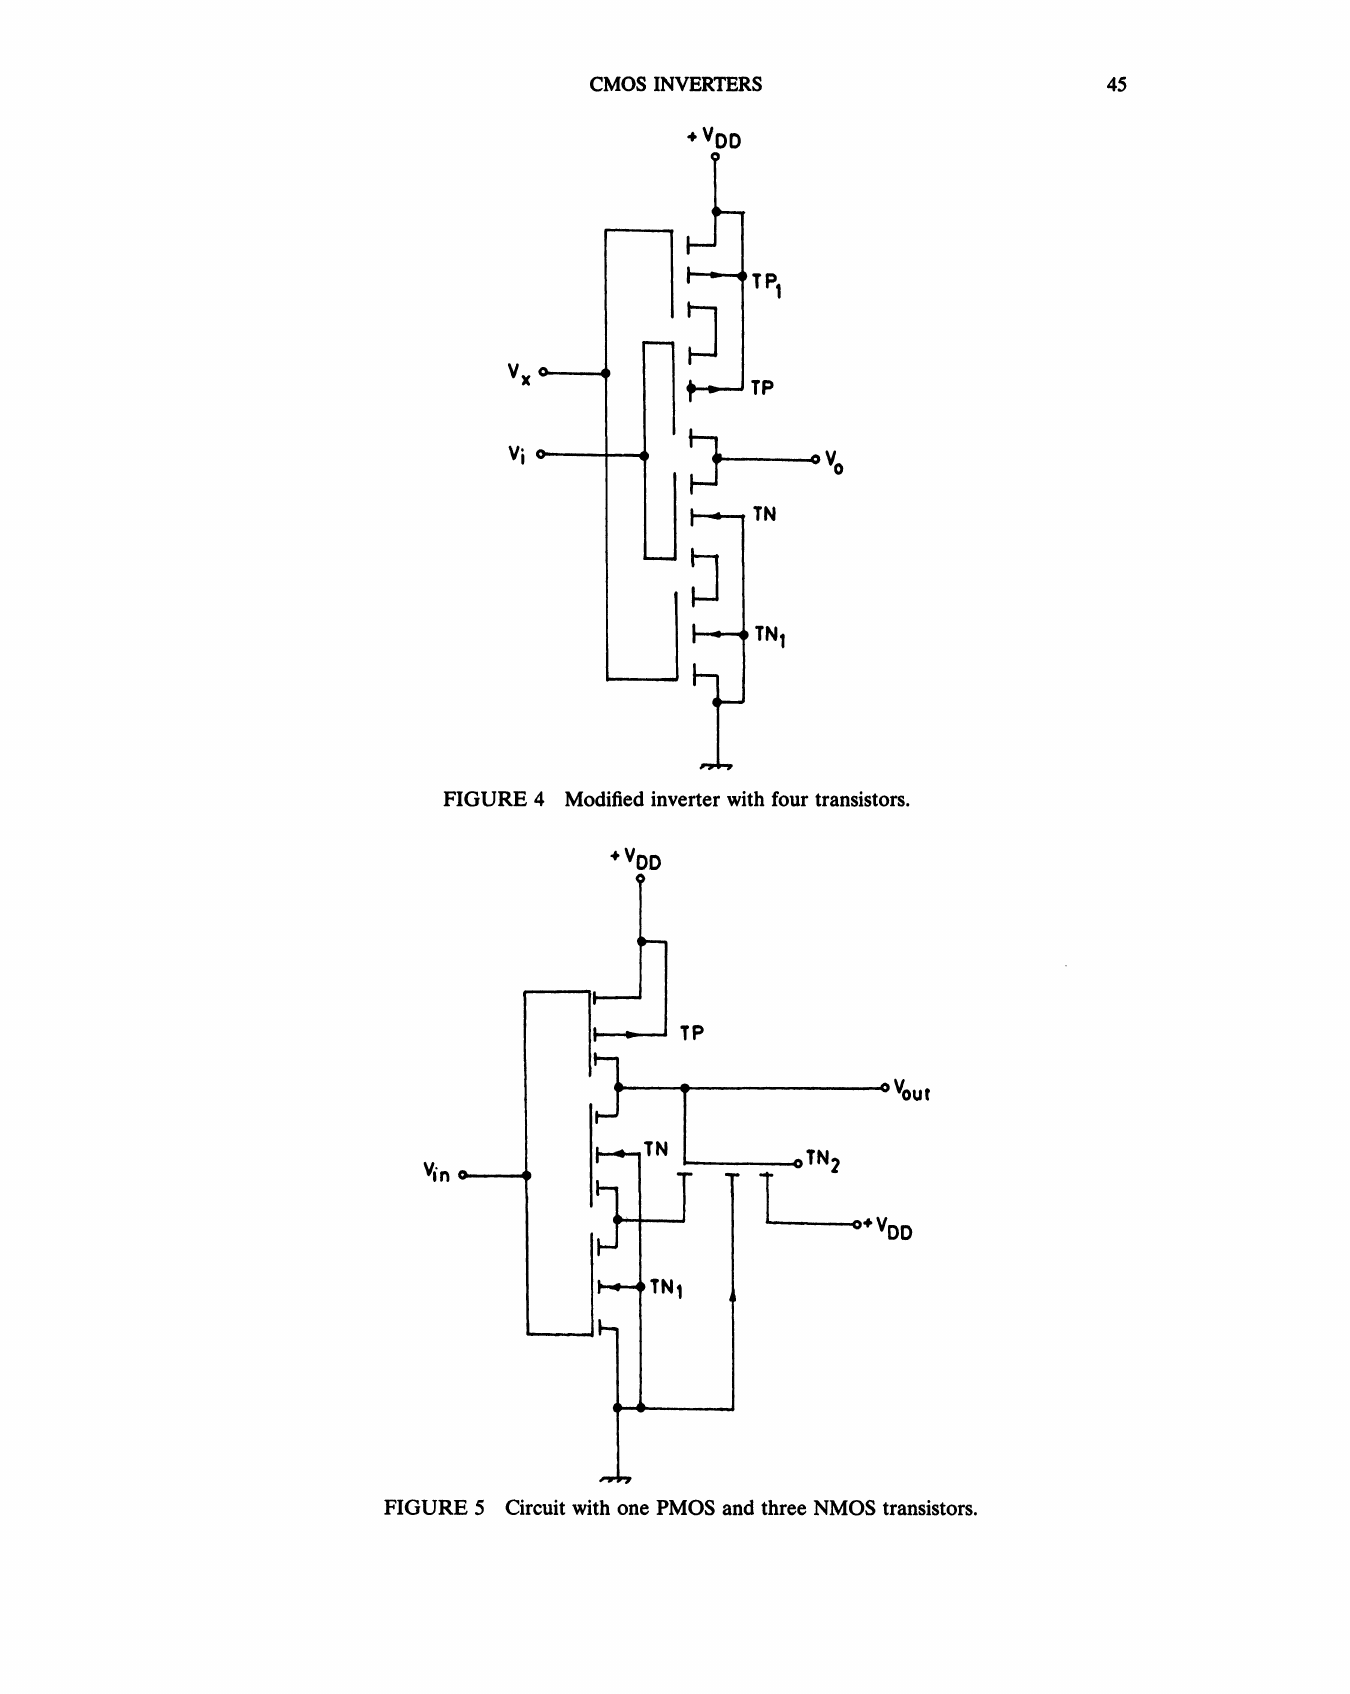
FIGURE 5 Circuit with one PMOS and three NMOS